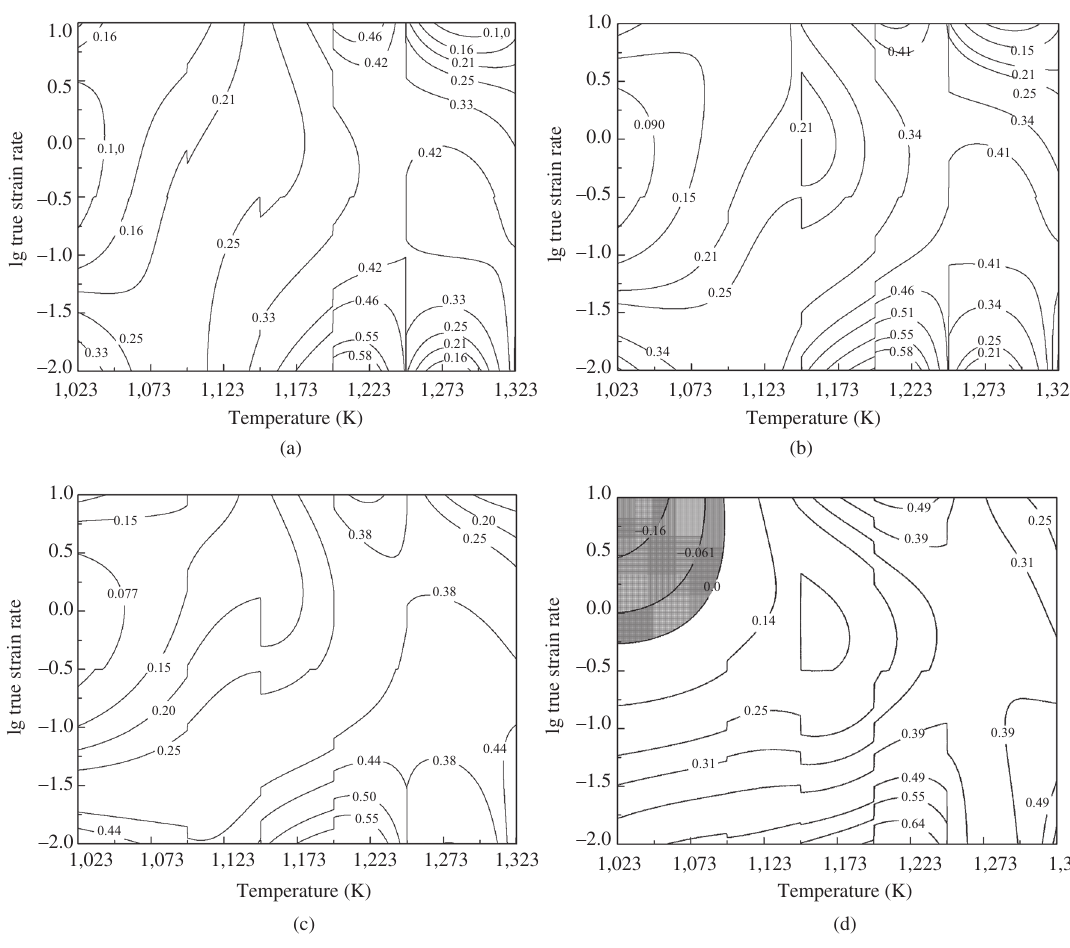
Figure 7 : Power dissipation maps for Ti – 6Al – 4V alloy as the true strain: (a) " ¼ 0 : 3 , (b) " ¼ 0 : 5 , (c) " ¼ 0 : 7 , (d) " ¼ 0 : 9